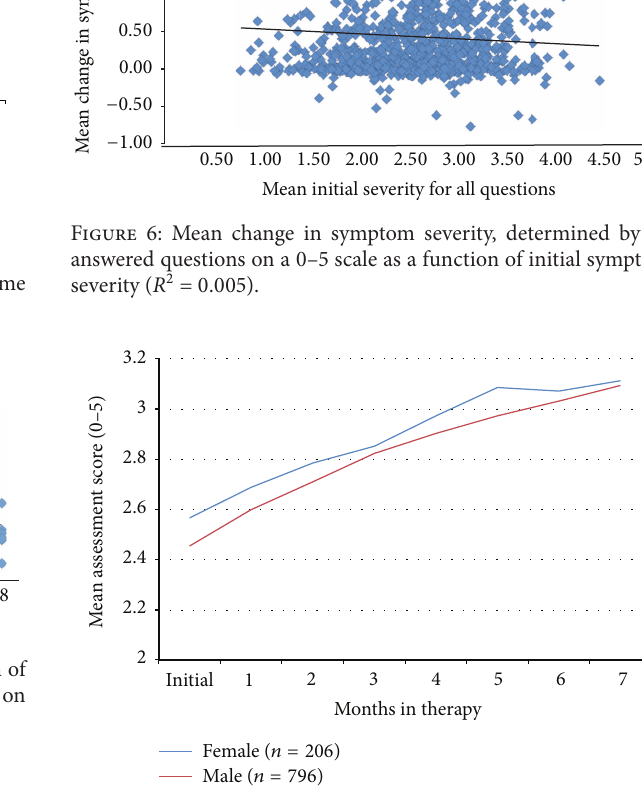
Figure 7: Mean composite assessment score (scale 0–5) over time for male and female